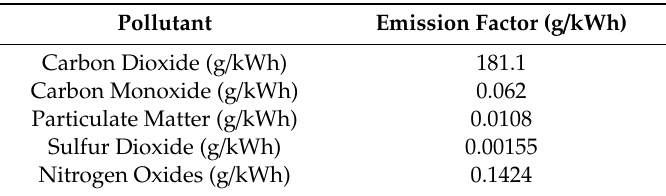
Table 5. Grid emissions